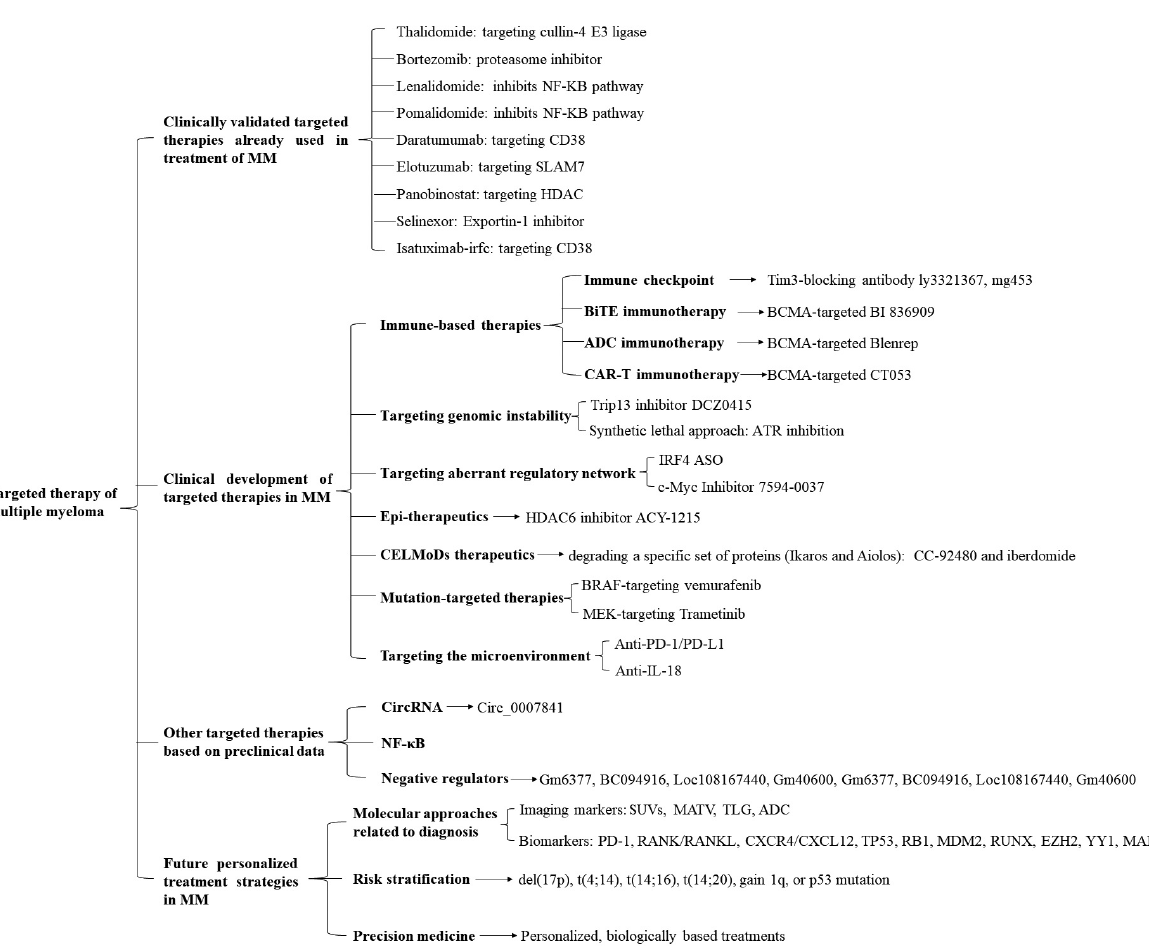
Figure 1. An overview of the different targeted therapies of therapeutic interest in MM. Targeted therapies are divided into 4 sections: 1. Clinically validated targeted therapies already used in treatment of MM including cullin-4 E3 ligase-targeted thalidomide, proteasome inhibitor bortezomib, NF-κB pathway inhibitor lenalidomide and pomalidomide, CD38-targeted daratumumab and isatuximab-irfc, SLAM7-targeted elotuzumab, HDAC-targeted panobinostat exportin-1 inhibitor selinexor; 2. Clinical development of targeted therapies in MM including immune-based therapies, targeting genomic instability, targeting aberrant regulatory network, epigenetic (Epi)-therapeutics, CELMoDs therapeutics, mutation-targeted therapies, targeting the microenvironment, and so on; 3. Other targeted therapies based on preclinical data including targeting CircRNA, NF-κB, negative regulators, and so on; 4. Future personalized treatment strategies in MM including molecular approaches related to diagnosis, risk stratification and precision medicine. SLAM7: signaling lymphocytic activation molecule family member 7; HDAC: histone deacetylase; Tim3: T cell immunoglobulin-3; BiTE: bispecific T-cell engager; BCMA: B-cell maturation antigen; ADC: antibody-drug conjugates;